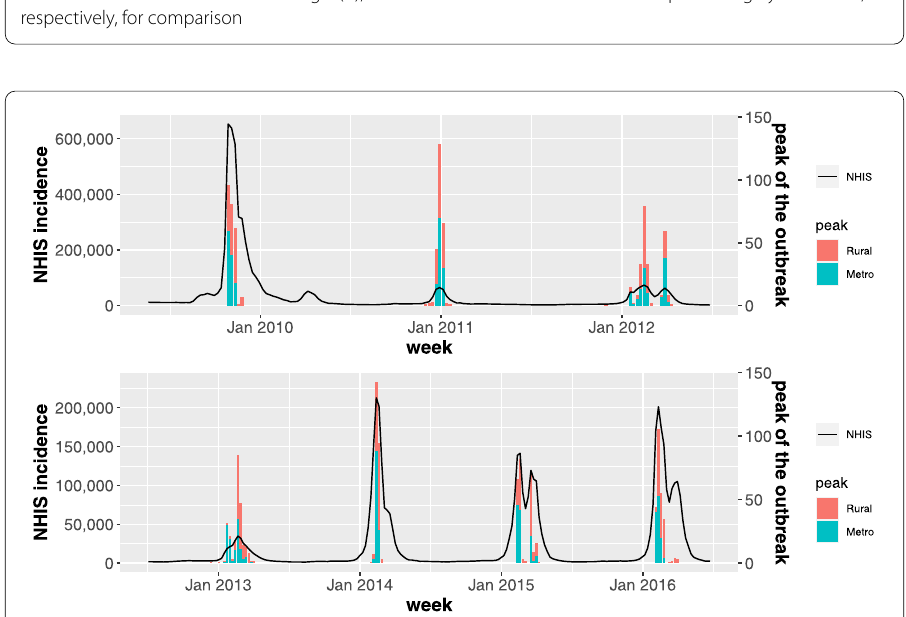
Figure 10 The histogram of the influenza peak weeks. The histogram represents the number of regions that have the influenza peak in that week. The black solid line represents the number of new